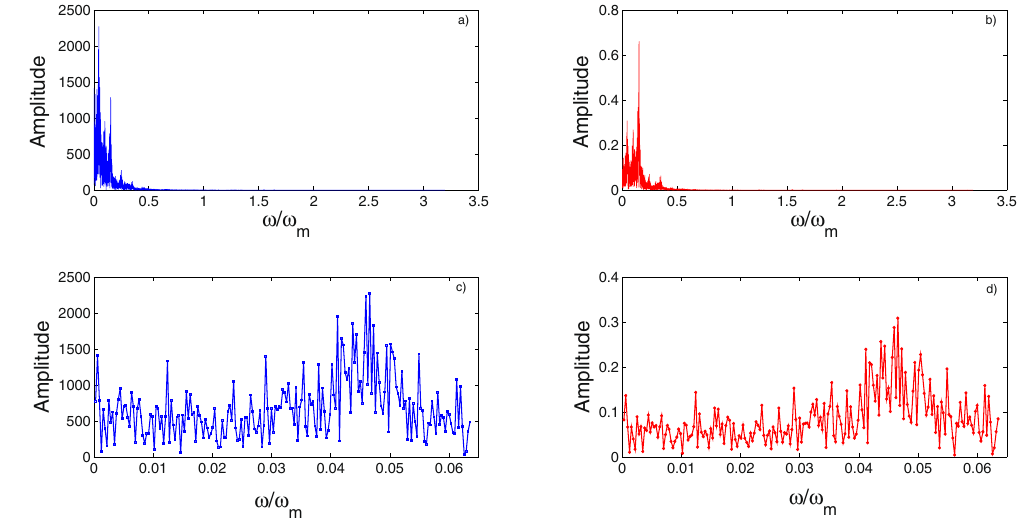
Figure 8. FFT analysis of the system when it is in double-driving mode and chaotic state. ( a ) and ( b ) are amplitude of mechanical and optical mode in frequency domain. ( c ) and ( d ) show a narrows frequency varying